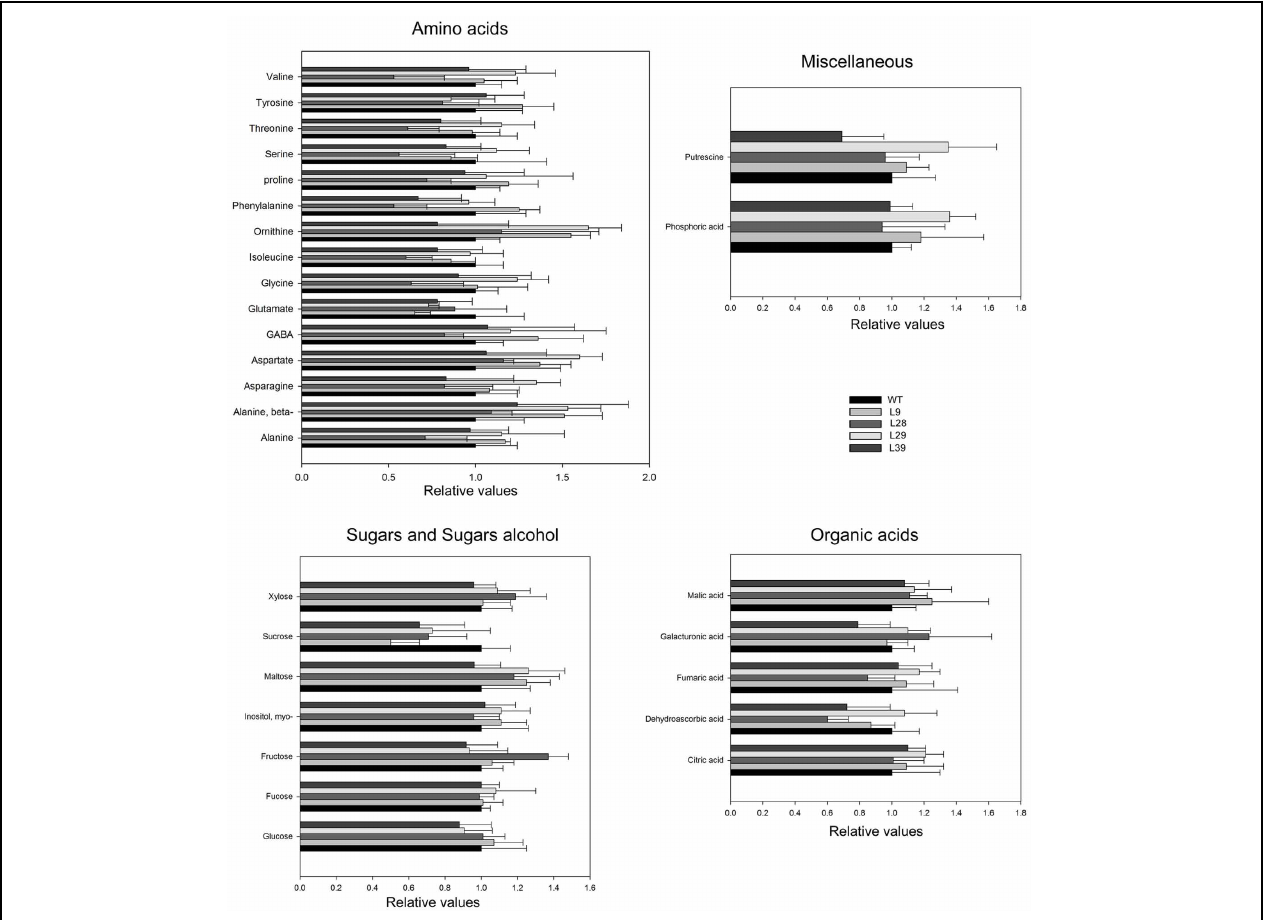
FIGURE 3 | Primary metabolite levels in the receptacle of WT and B33-PPi lines at green stage. Data are normalized to the mean value of WT at the G stage. Values are means SE of six replicates. Asterisks indicate significant differences by t -test ( P < 0 . 01) of the transgenic lines compared with WT at green